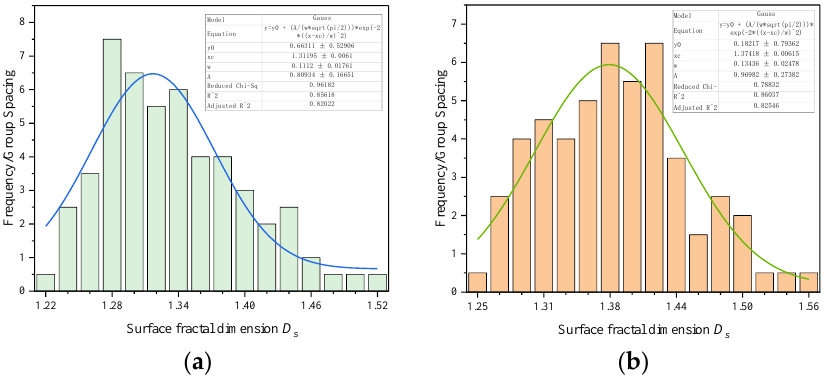
Figure 6. Schematic Diagram of Surface Fractal Dimension Calculation. Figure 7. The distribution statistics of surface fractal dimension. ( a ) Surface fractal dimension D S of QSGS. ( b ) Surface fractal dimension D S of FE-SEM image.